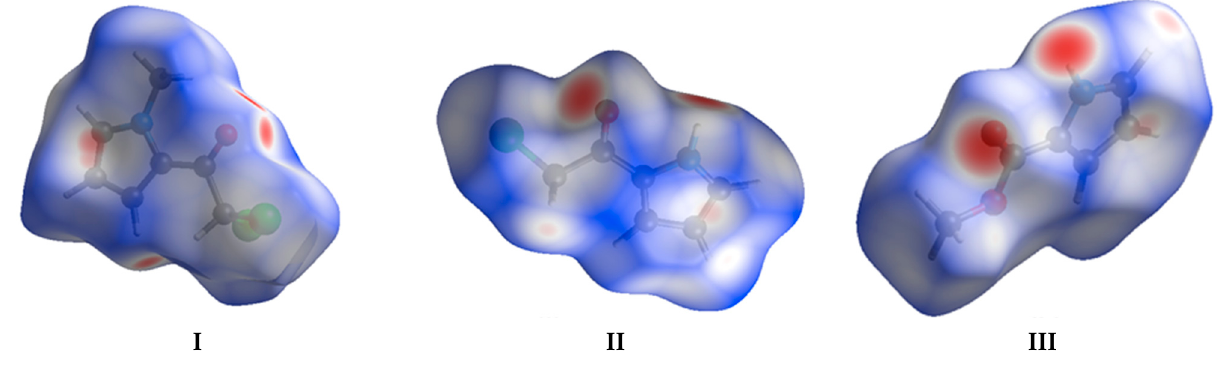
Figure 7. Hirshfeld surfaces of compound I - III mapped over d norm .